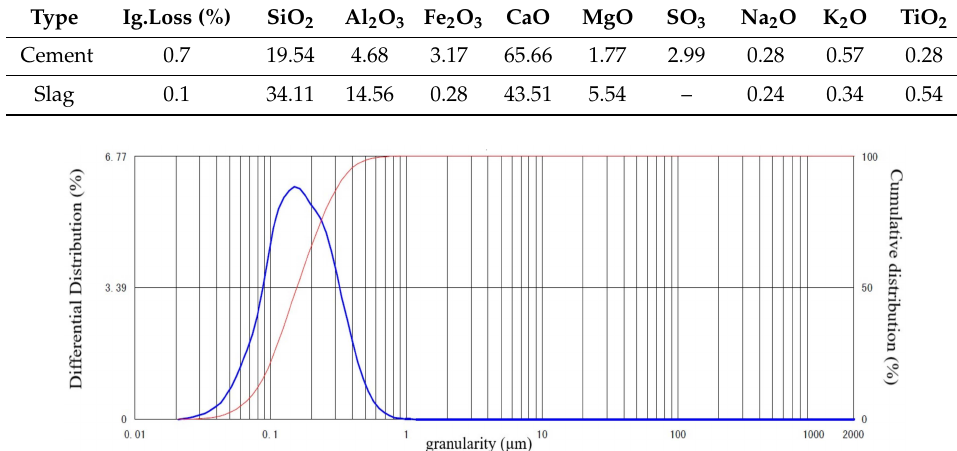
Table 2. Chemical composition of cement and slag.